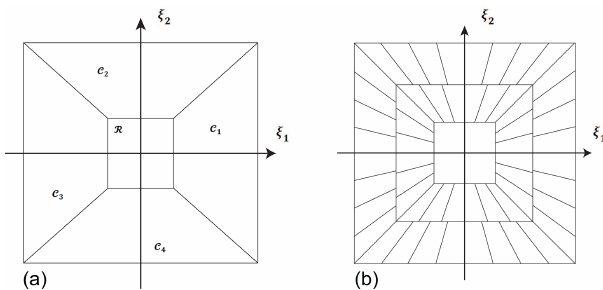
Figure A2. The cone-adapted continuous shearlet system. (a) Bias in directions is handled by dividing the frequency plane into four cones C 1 , C 2 , C 3 , C 4 , and a square low-frequency box region in the centre R . (b) Trapezoidal-shaped wedge tiling of the frequency- induced domain induced by the shearlet transform (modified after Kutyniok and Labate,